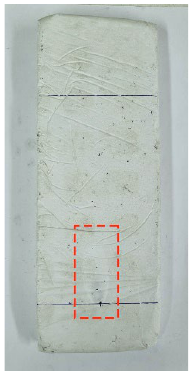
Figure 16. Flame mark length.